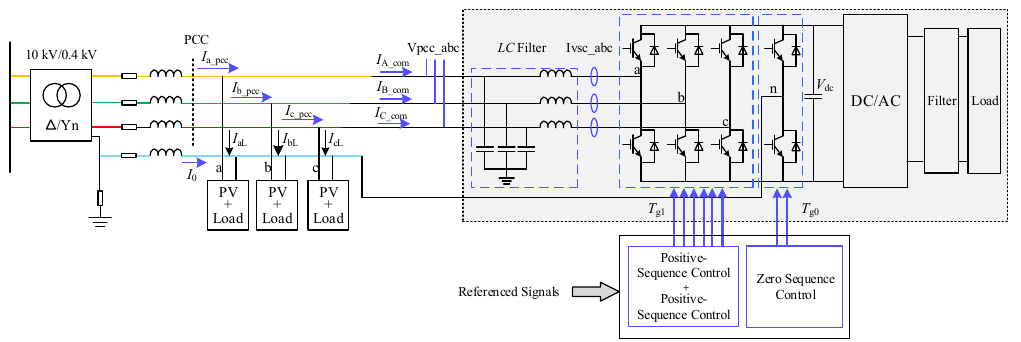
Figure 4. Three-phase imbalance mitigation control system utilizing AAEA Unit.